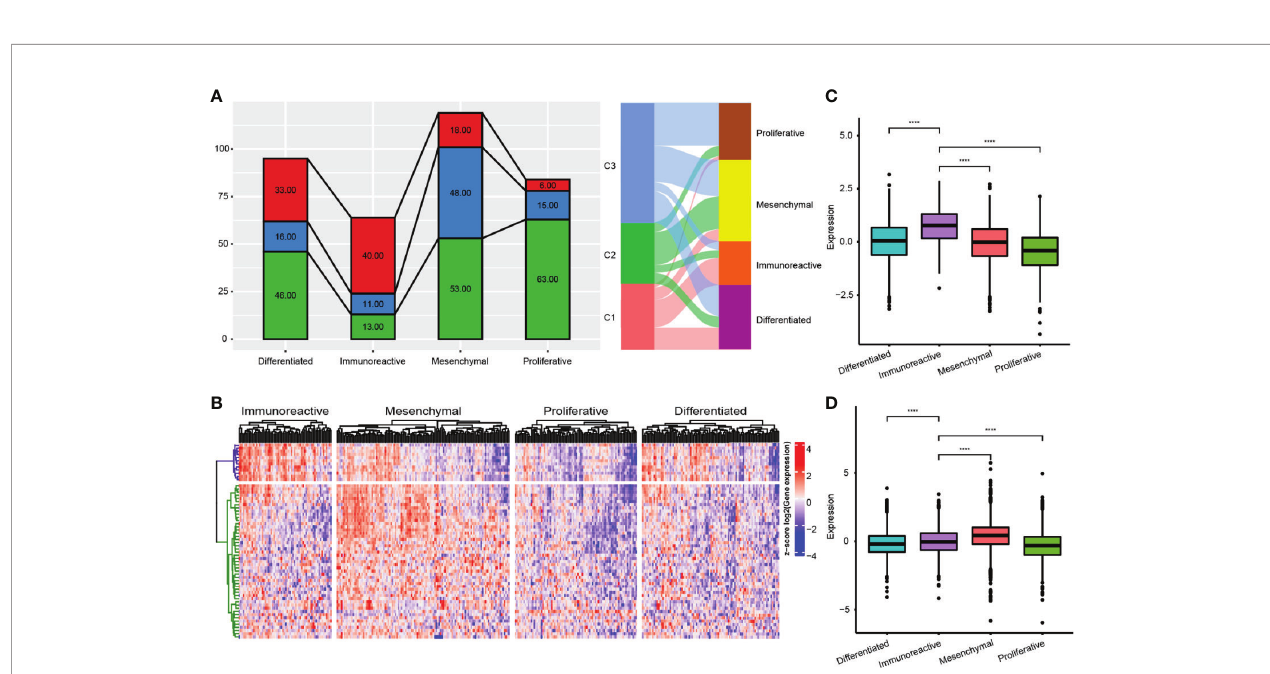
FIGURE 7 | Comparison of immune subtypes and existing subtypes. (A) The intersection of molecular subtypes and immune subtypes in TCGA. (B) Clustering heatmap of prognosis related immune genes in four subtypes. (C) Differential distribution of G1 gene set expression among immune subtypes. (D) Differential distribution of G1 gene set expression among immune subtypes. ****P <